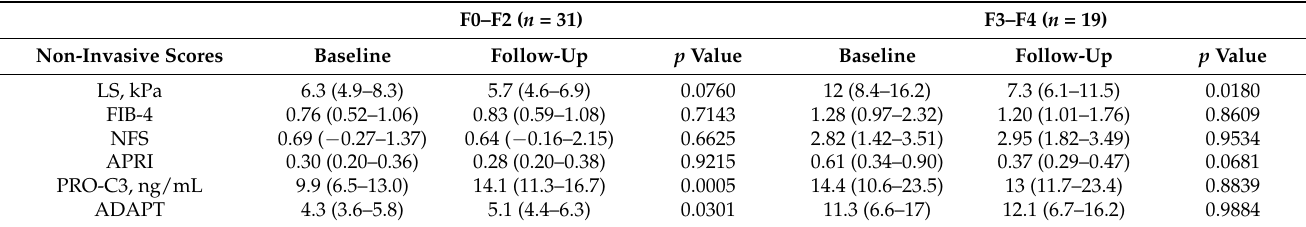
Table 5. Comparison of non-invasive tests between baseline and follow-up. F0–F2 ( n = 31) F3–F4 ( n =